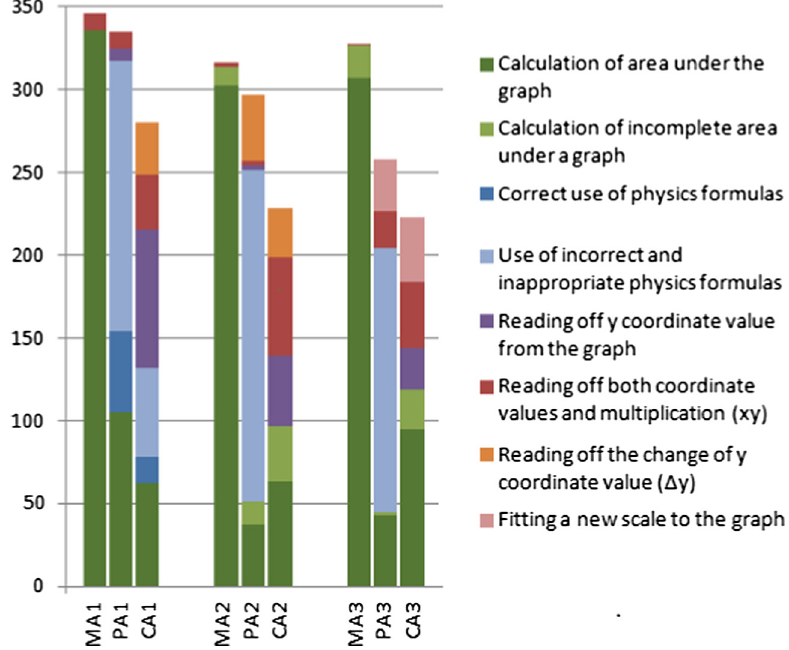
FIG. 3. Overview of student strategies on area questions and their frequencies (number of students who used